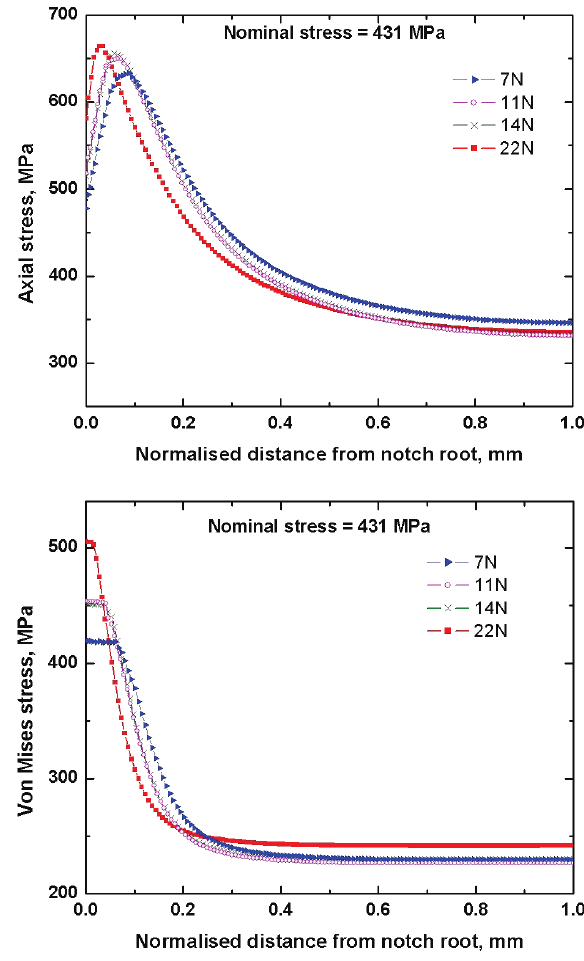
Figure 13. Variation of stress in the minimum